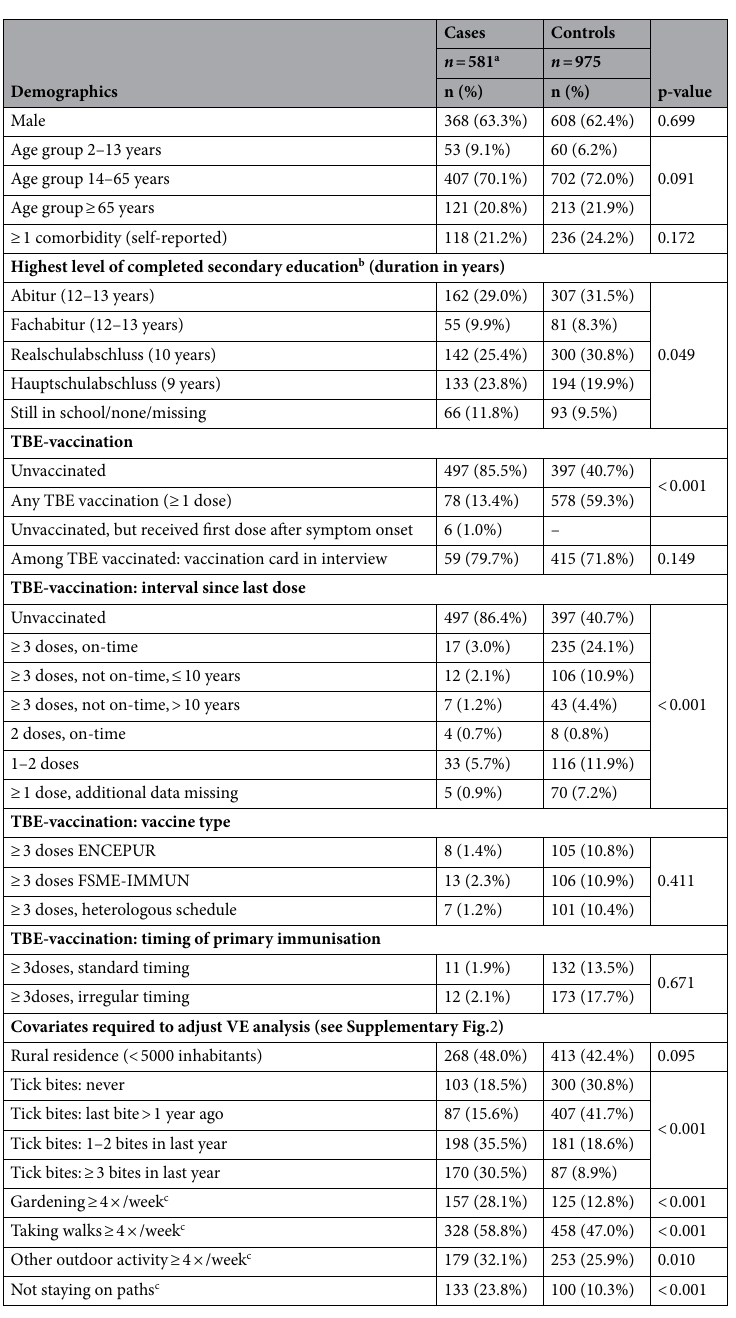
Table 1. Participant characteristics: demographics, TBE vaccination status, and covariates required to adjust vaccine effectiveness analysis (see Supplementary Fig. 2). a 558 cases and all controls had interview data, used as denominator for solely interview-derived variables (education and parameters from rural residence onwards). b English translations: Abitur = general qualification for university